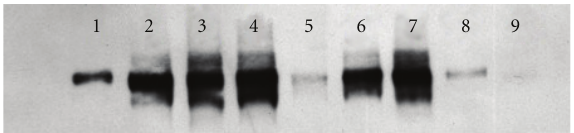
Figure 3: Western blot of the P-glycoprotein on placenta perfused at 30 and 40g/L of albumin ( n = 8). Control was on the left. Sample 1 was control sample; sample 9 was not visible at this time of